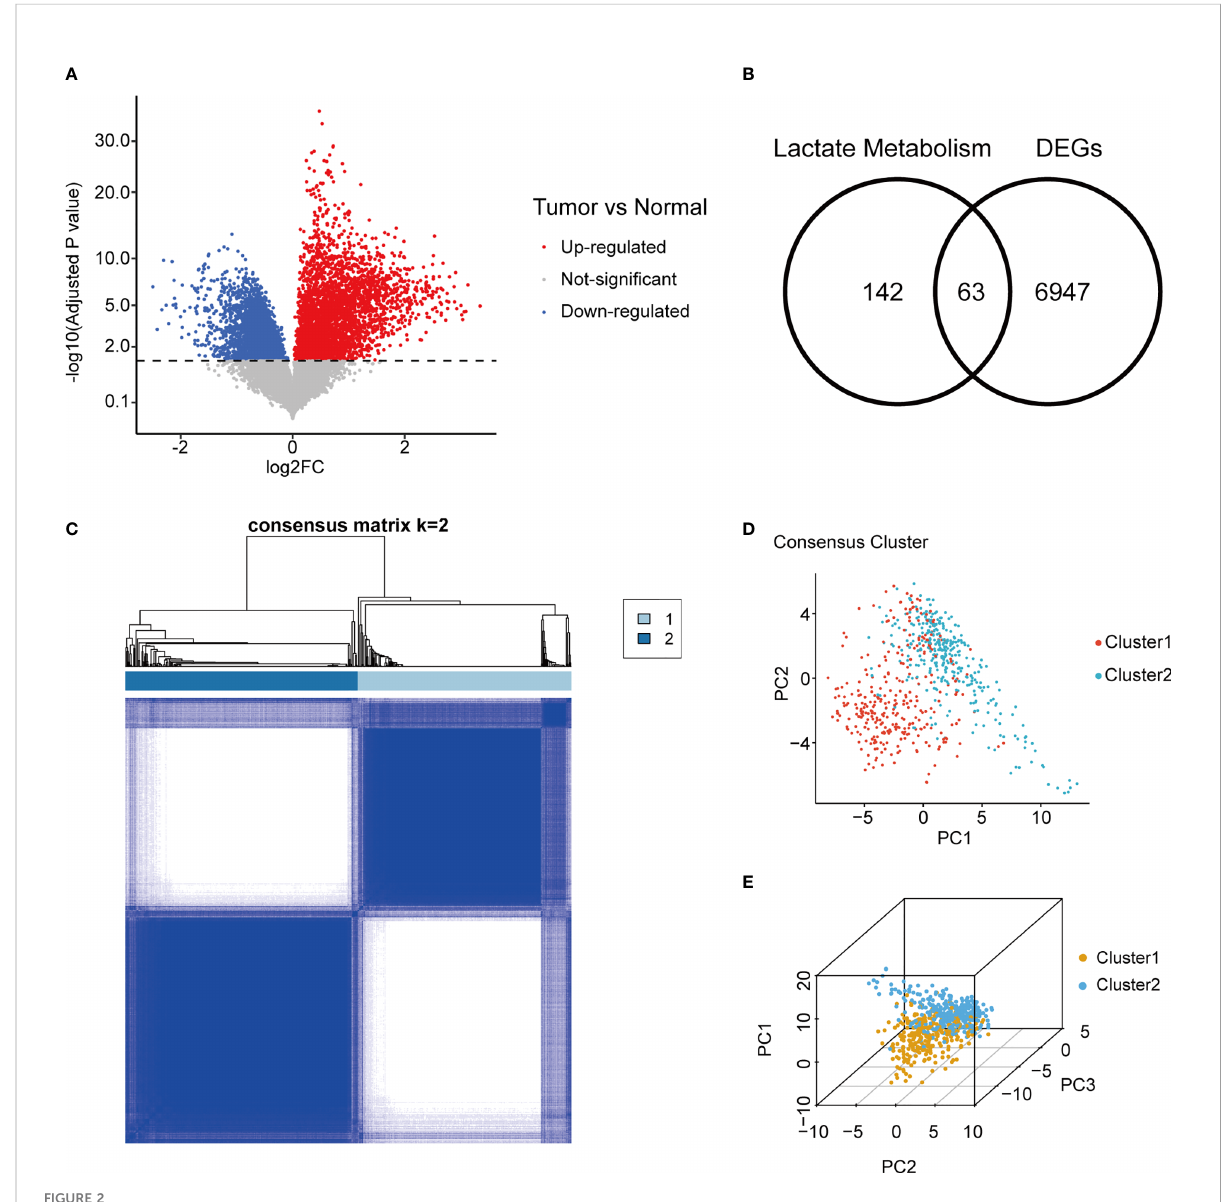
FIGURE 2 Consensus clustering of gliomas using LMG expression. (A) Volcano plot of gene fold change between adult primary glioma samples and normal brain in TCGA. (B) Overlap between tumor/normal DEGs and lactate metabolism related genes. (C) Consensus matrix of two LMGs clusters. (D, E) Concordance between two and three dimensional PCA of LMG expression and consensus clusters. LMG, lactate metabolism- related gene; TCGA, The Cancer Genome Atlas; DEG, differentially expressed gene; PCA, principal component